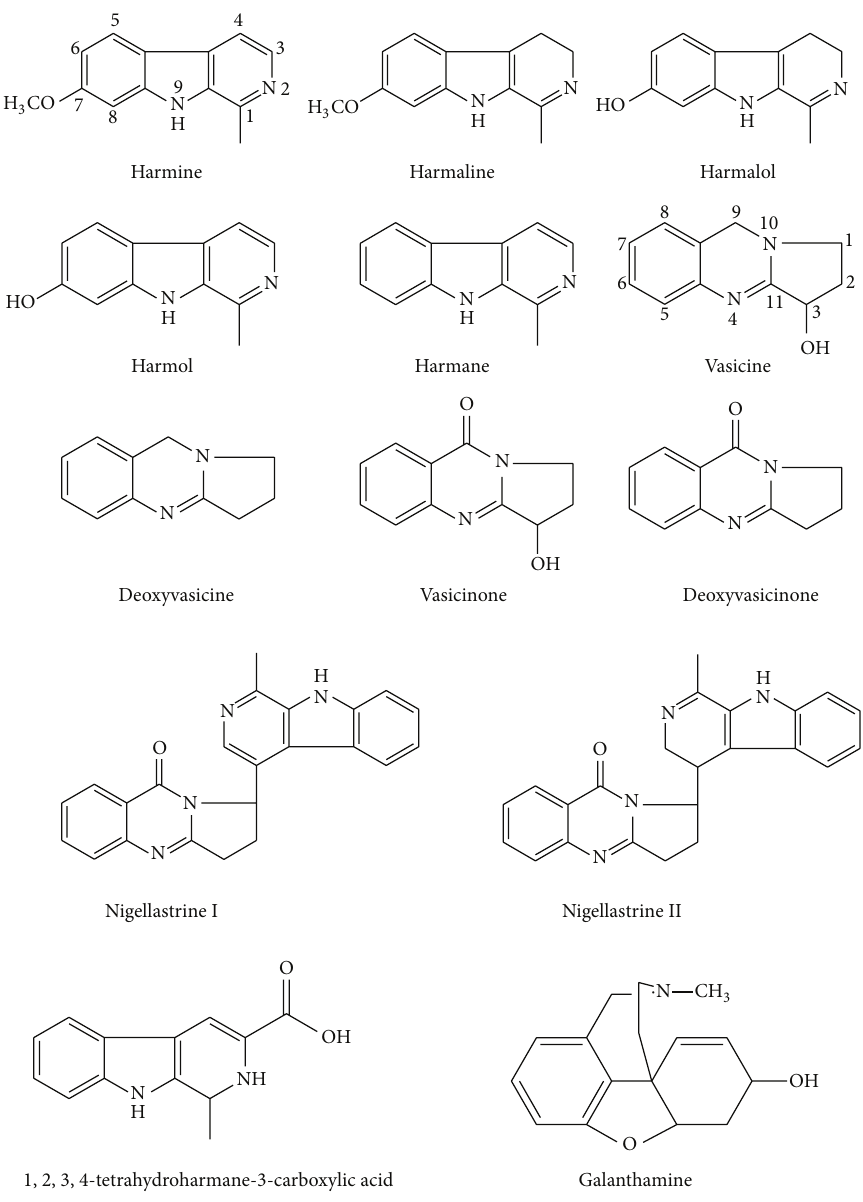
Figure 1: Structures of the compounds